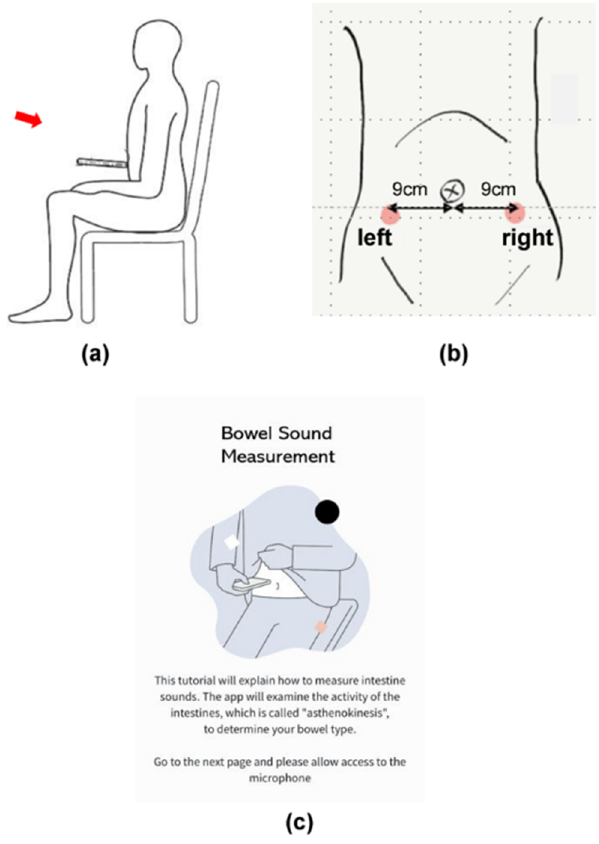
Figure 1. Bowel sound measurement positions. ( a ) Seated recording posture; ( b ) microphone placement over the lower right and left parts of the abdomen; ( c ) a smartphone screen showing the measurement instructions.